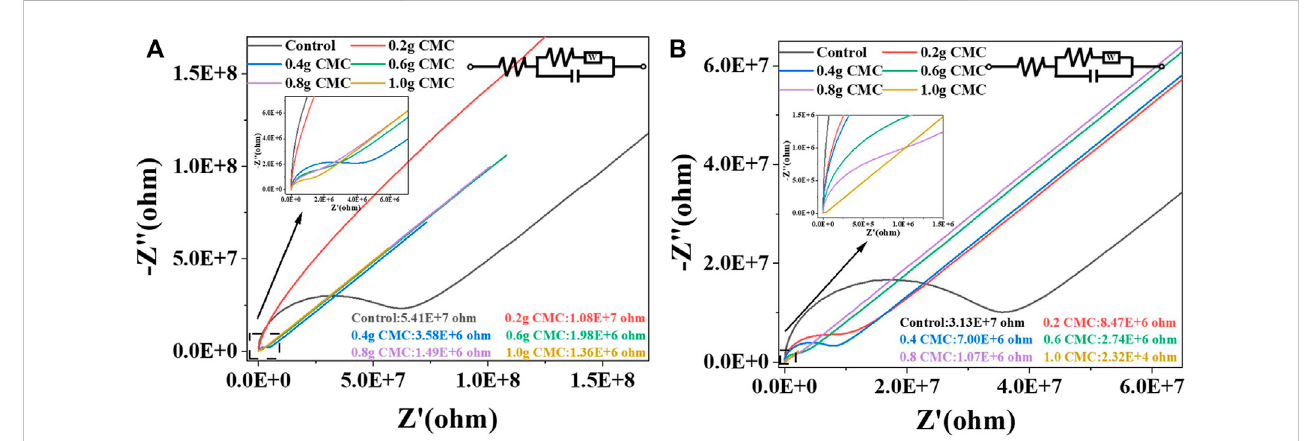
EIS of the starch/CMC composite fi lms. (A) : CS/CMC composite fi lms; (B) : CA/CMC composite fi lms.